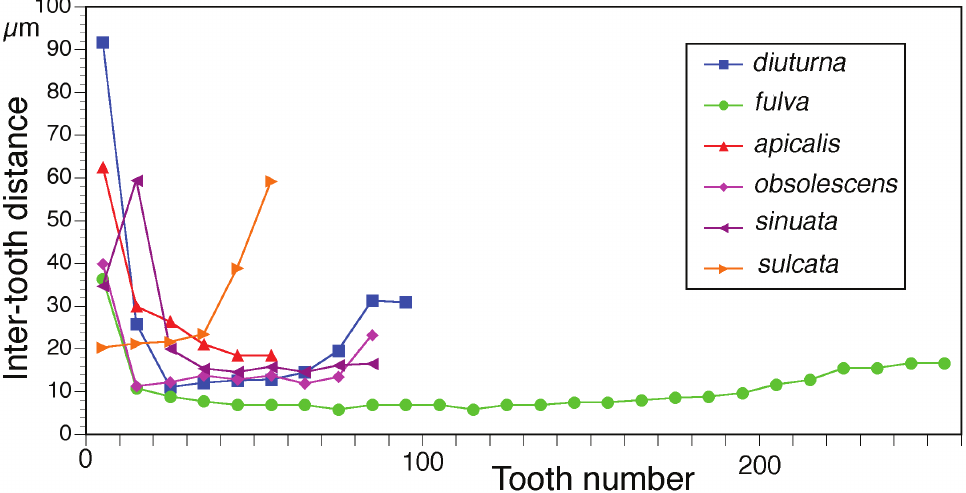
Figure 2. Inter-tooth spacing in male stridulatory files of Ectadia species.